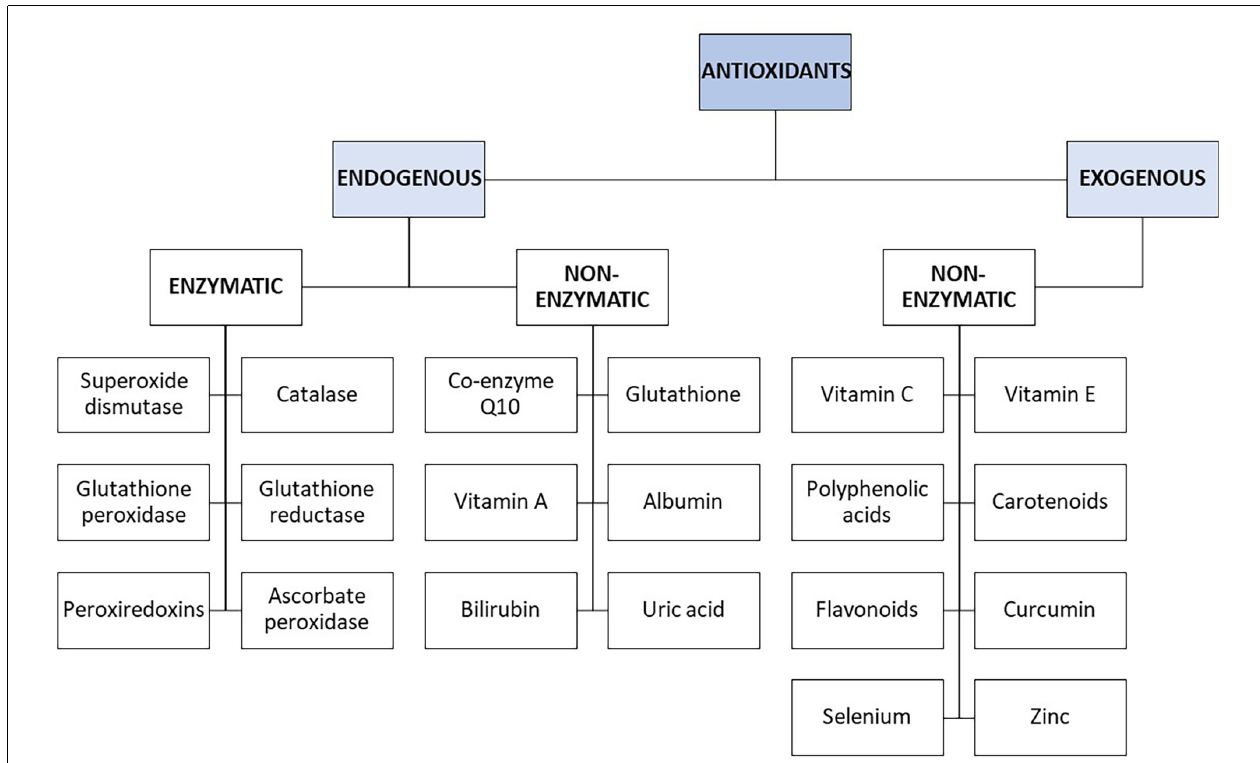
FIGURE 4 | Schematic diagram of endogenous and exogenous enzymatic and non-enzymatic antioxidants.